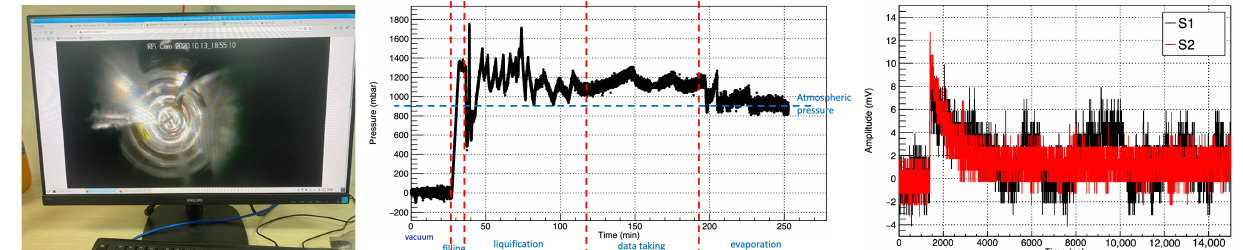
Figure 3. A camera image of the liquid argon at the bottom of the chamber ( left ), the chamber pressure as a function of time through the operations ( center ) and the waveforms from a single cosmic muon event recorded by both TPB-coated SiPMs ( right ).